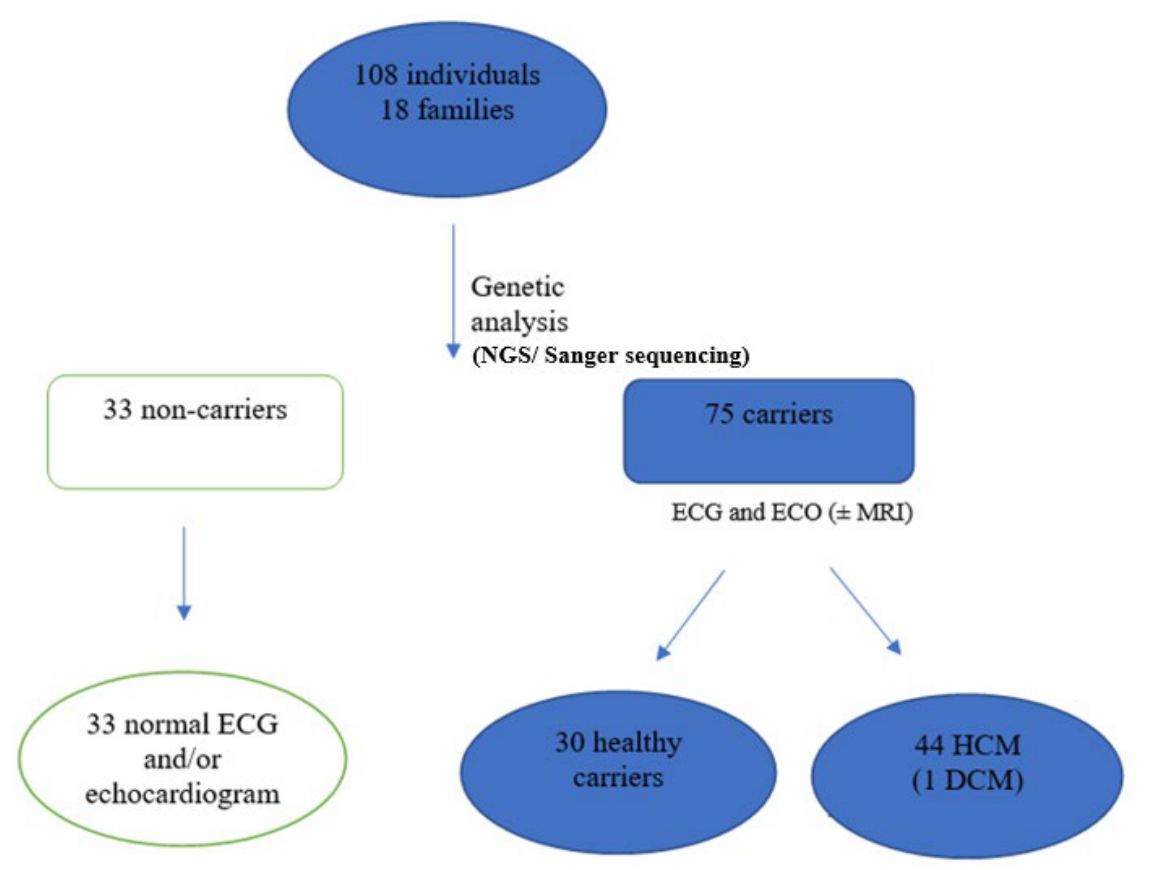
cardiological Figure 1. Central figure which represents the flow of participants in the genetic study and the car- diological study.